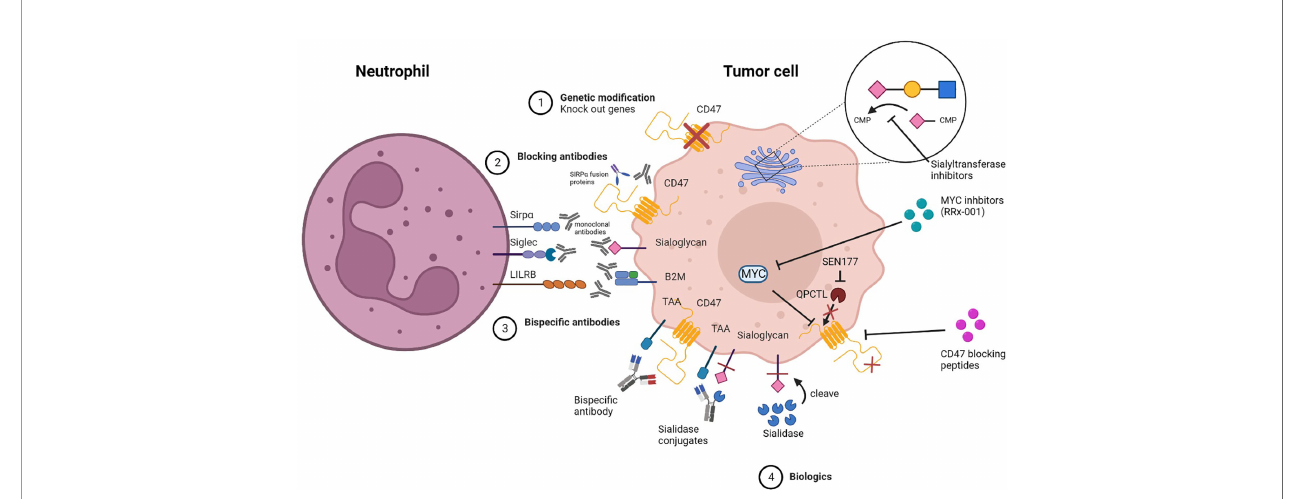
FIGURE 5 | Strategies for inhibiting myeloid checkpoints. 1) Genetic knock out of target genes involved in the inhibitory pathway. 2) Speci fi c blocking of target checkpoint molecules with mAbs or soluble ligand-Fc fusion proteins to inhibit receptor binding and checkpoint axis activation. 3) Bispeci fi c antibodies that target both TAA and checkpoint molecules simultaneously to avoid off-target side effects.4) Biologics that alter the structure of the target protein, preventing it from binding to the receptor, or that inhibit expression or block the target